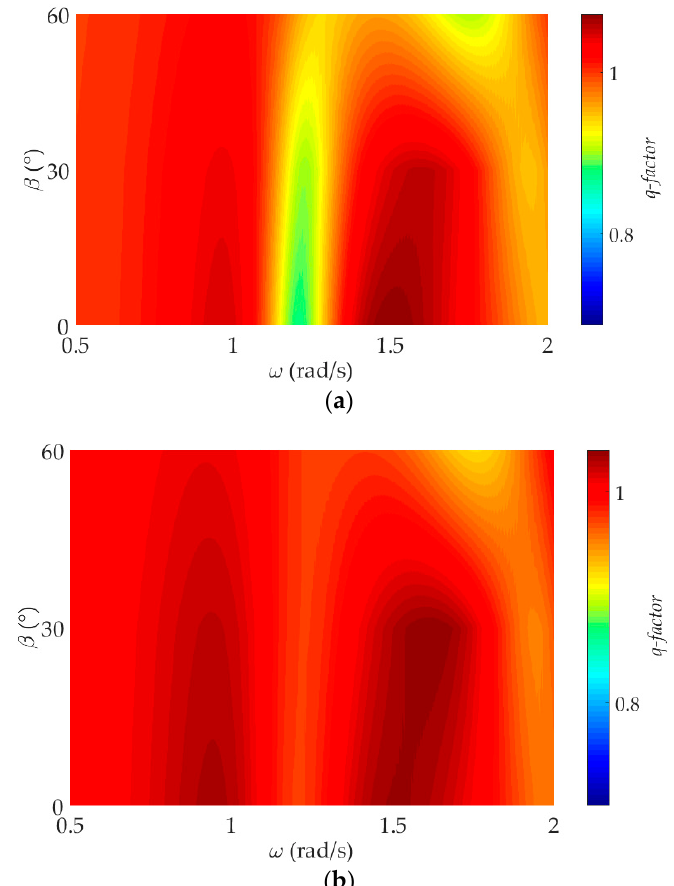
Figure 9. q-factor as a function of the wave frequency (rad/s) for different wave-heading angles (°): ( a ) Without PTO, and ( b ) With PTO.